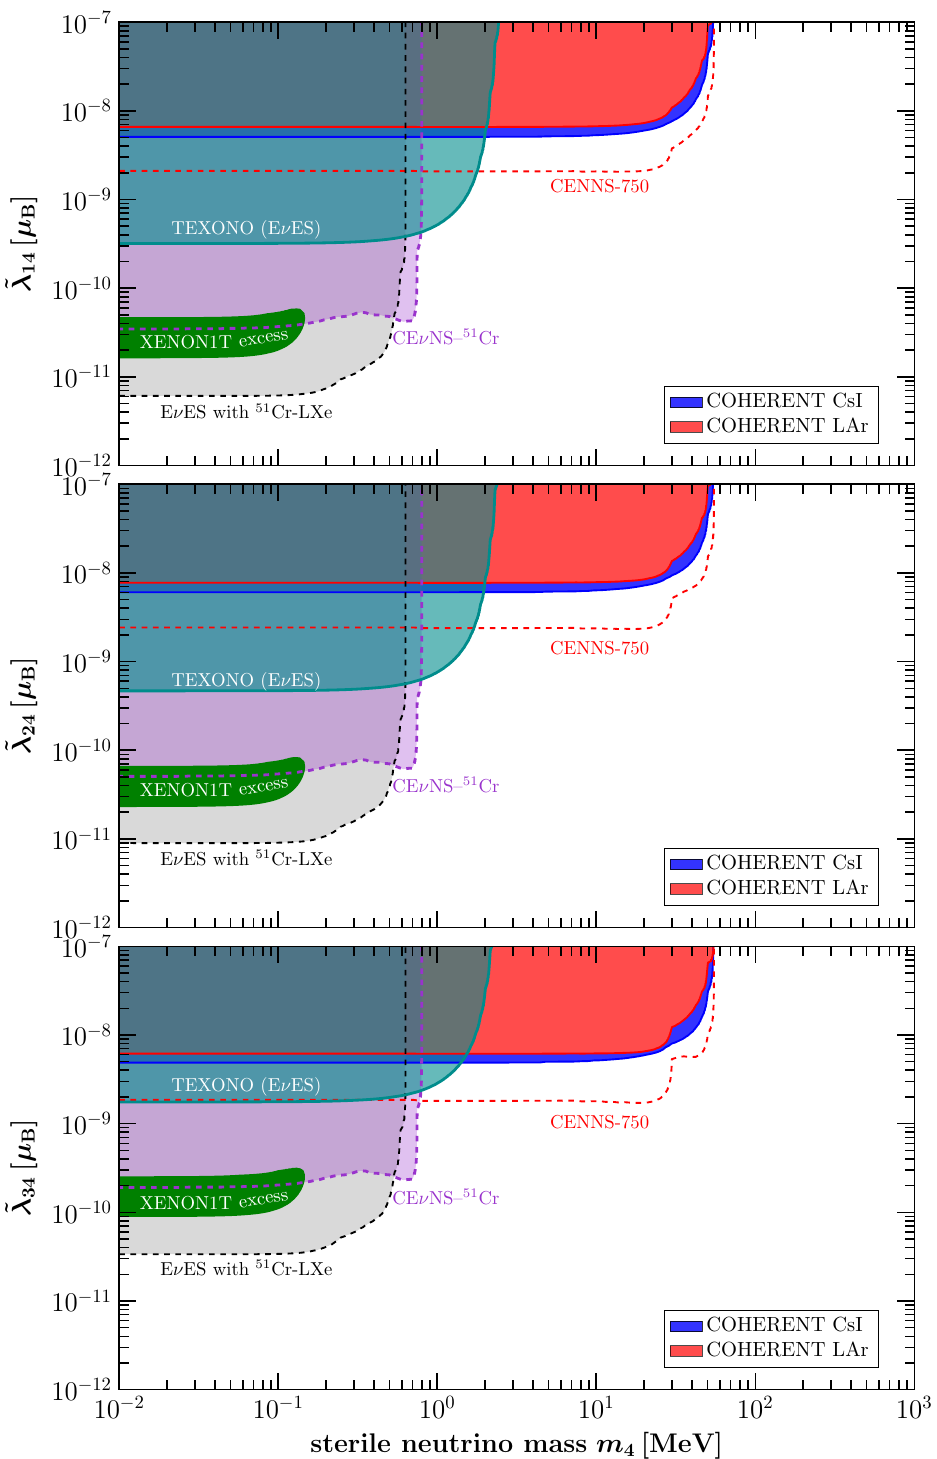
Figure 4 . Sensitivity of CE ν NS and E ν ES experiments in terms of the general TMM description. Note that our TMM notation provides a common basis for describing all possible experimental setups, see